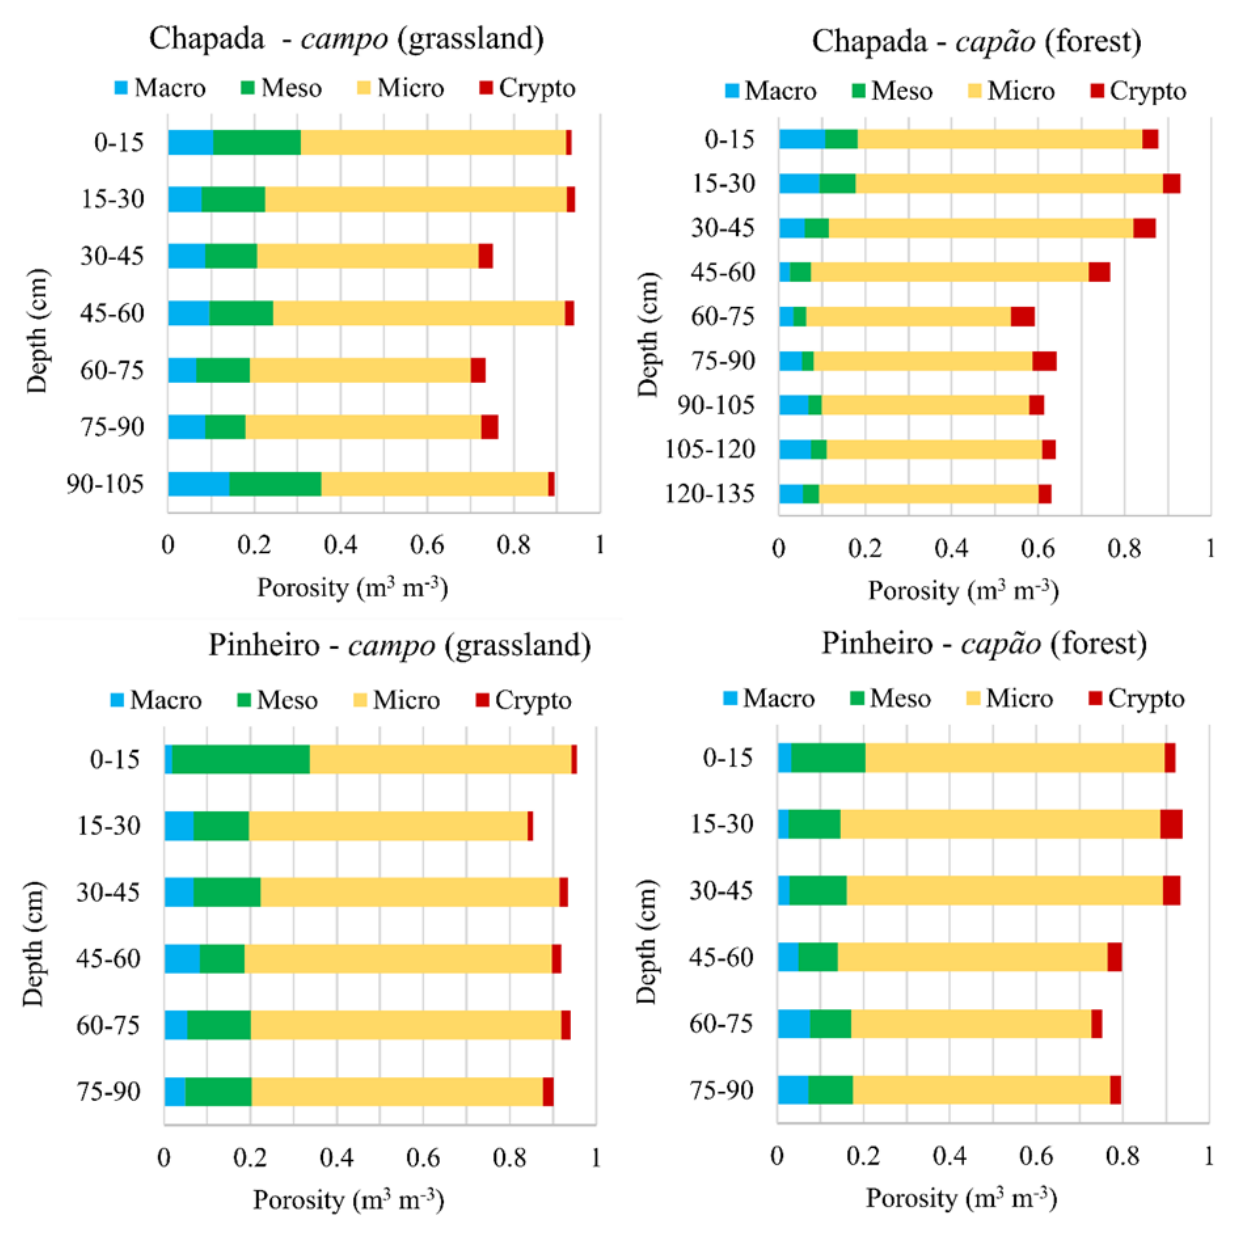
Figure 7. Discrete pore size distribution in the classes macropores, mesopores, micropores and cryptopores for the evaluated layers from both peatlands (Chapada and Pinheiro) under forest ( campo ) and grassland ( capão )